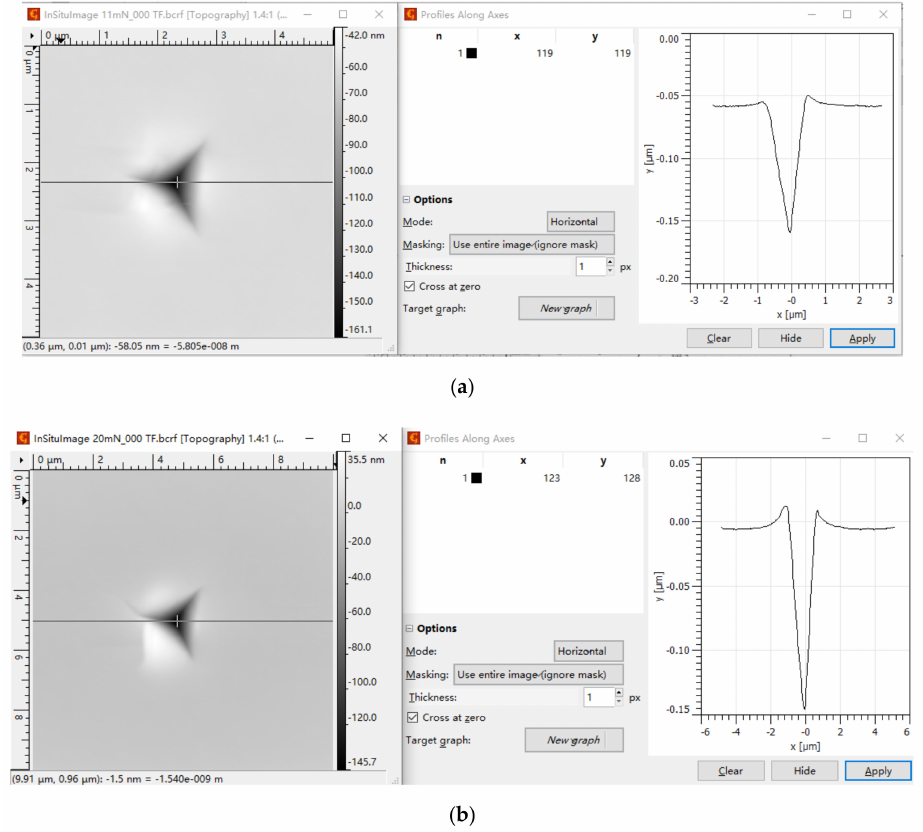
Figure 13. Indentation depths of LN at 11 mN and 20 mN. ( a ) 11 mN Load Indentation Depth; ( b ) 20 mN Load Indentation